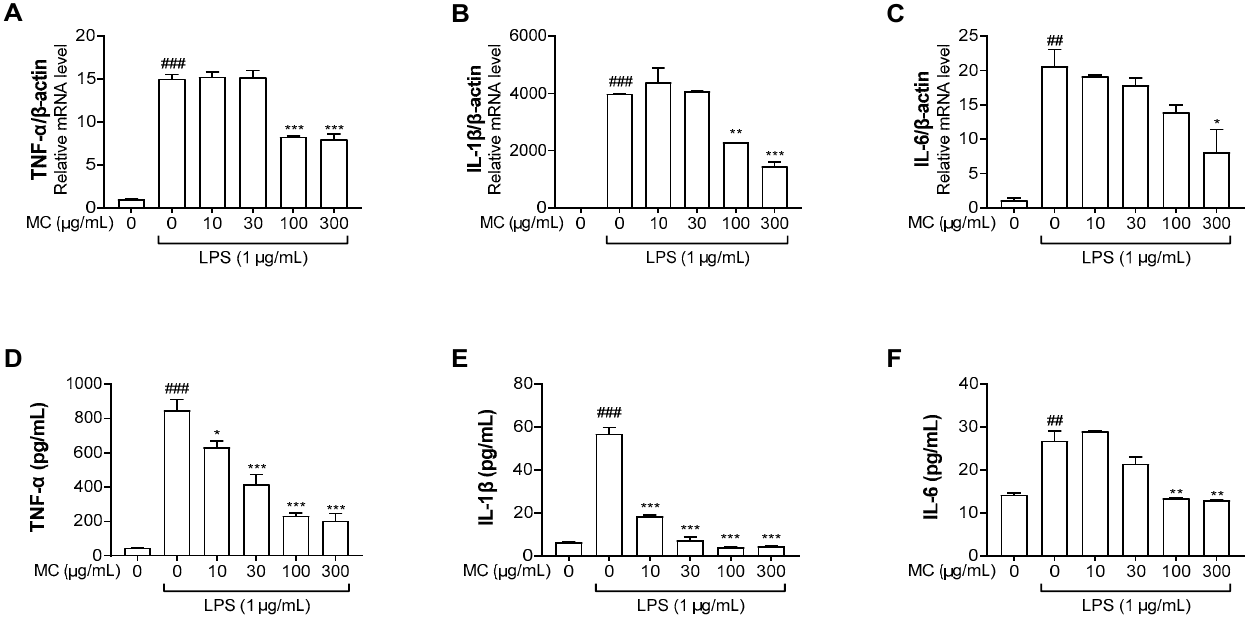
Figure 3. Effects of M. concanensis on LPS − stimulated proinflammatory cytokine expression in HaCaT keratinocytes. Cells were pretreated with M. concanensis (MC) for 1 h before LPS stimulation (1 µ g/mL) for 24 h. The level of mRNA expressions of TNF- α , IL-1 β and IL-6 was determined by RT-qPCR ( A – C ). The level of TNF- α , IL-1 β and IL-6 proteins was measured by ELISA kits ( D – F ). The data presented are the mean of three independent determinations and indicate the mean ± S.E.M. ## p < 0.01, ### p < 0.001 compared to the vehicle-treated controls; * p < 0.05, ** p < 0.01 and *** p < 0.001 compared to the LPS-treated group.